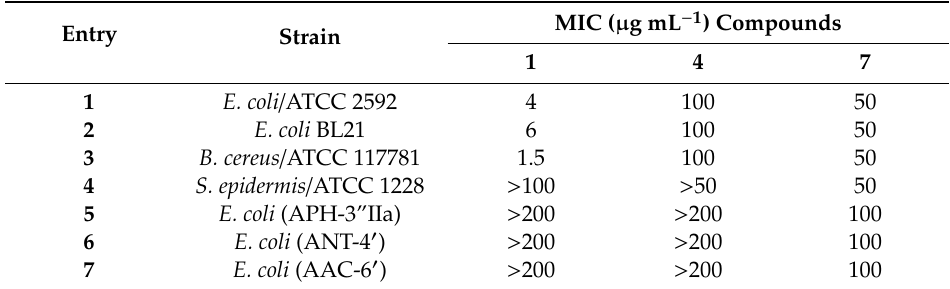
Table 1. MIC values of kanamycin A ( 1 ), neamine ( 4 ) and compound 7 against non-resistant and resistant strains.